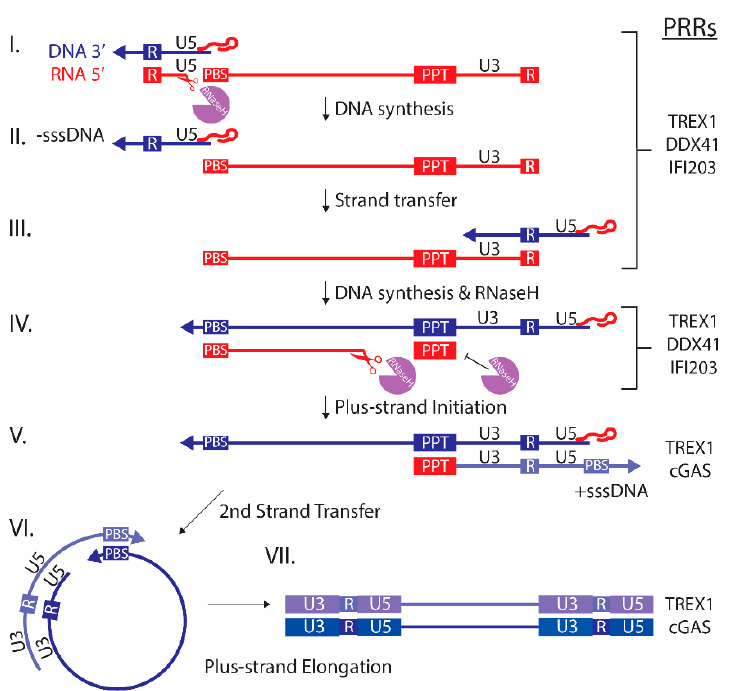
Figure 1. Retroviral reverse transcription. ( I ) Cellular tRNA binds to the primer binding site (PBS) in the Unique 5 ′ Region (U5) region of the RNA, initiating minus-strand DNA synthesis. ( II ) Synthesis